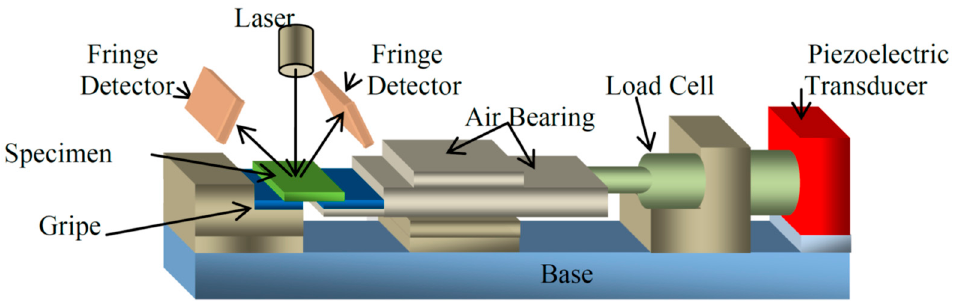
Figure 11. The measurement system for Poisson’s ratio, modulus of elasticity, and tensile strength for polysilicon.